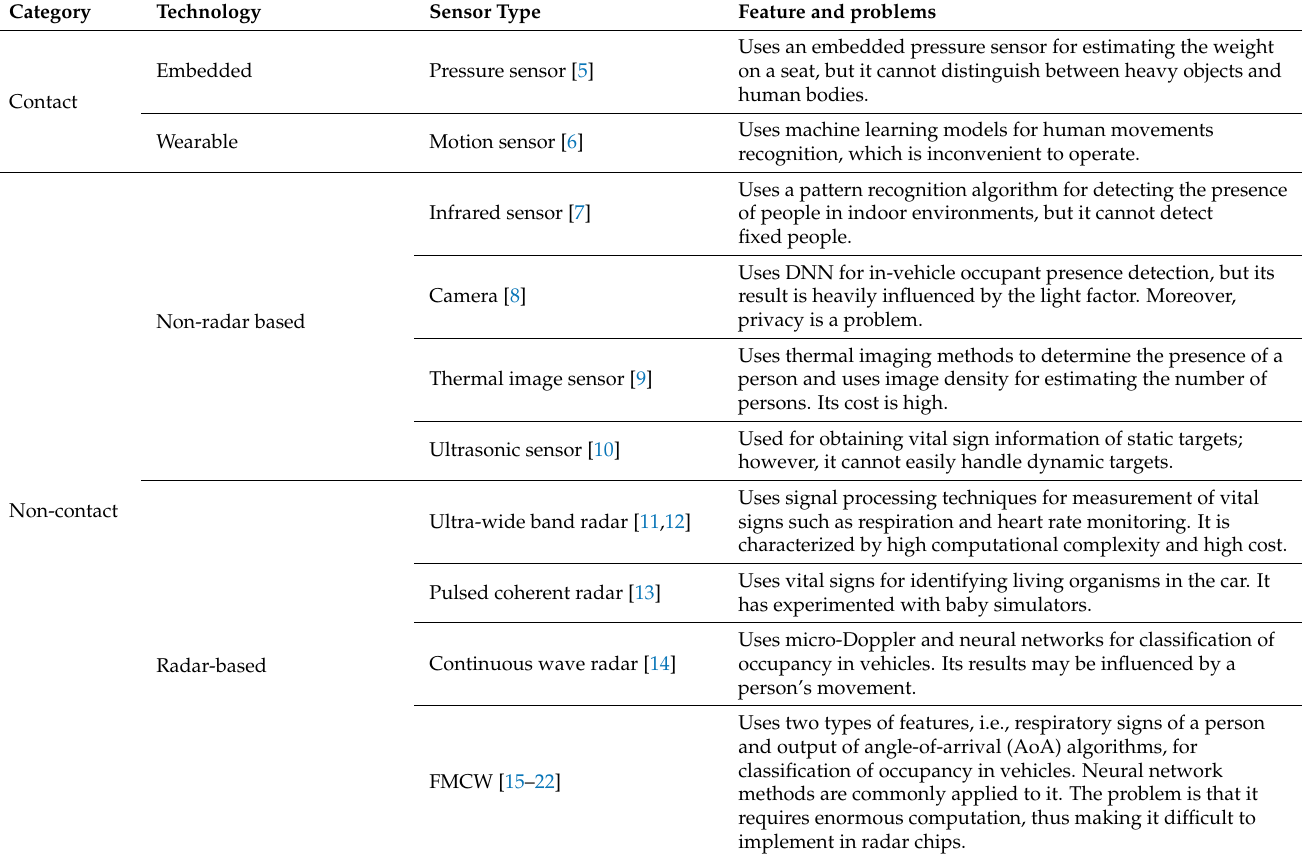
Table 1. Comparison of different monitoring